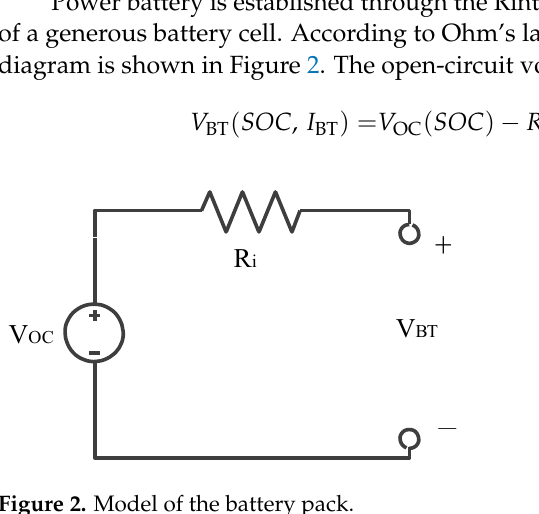
Figure 1. Efficiency diagram of the motor or generator.